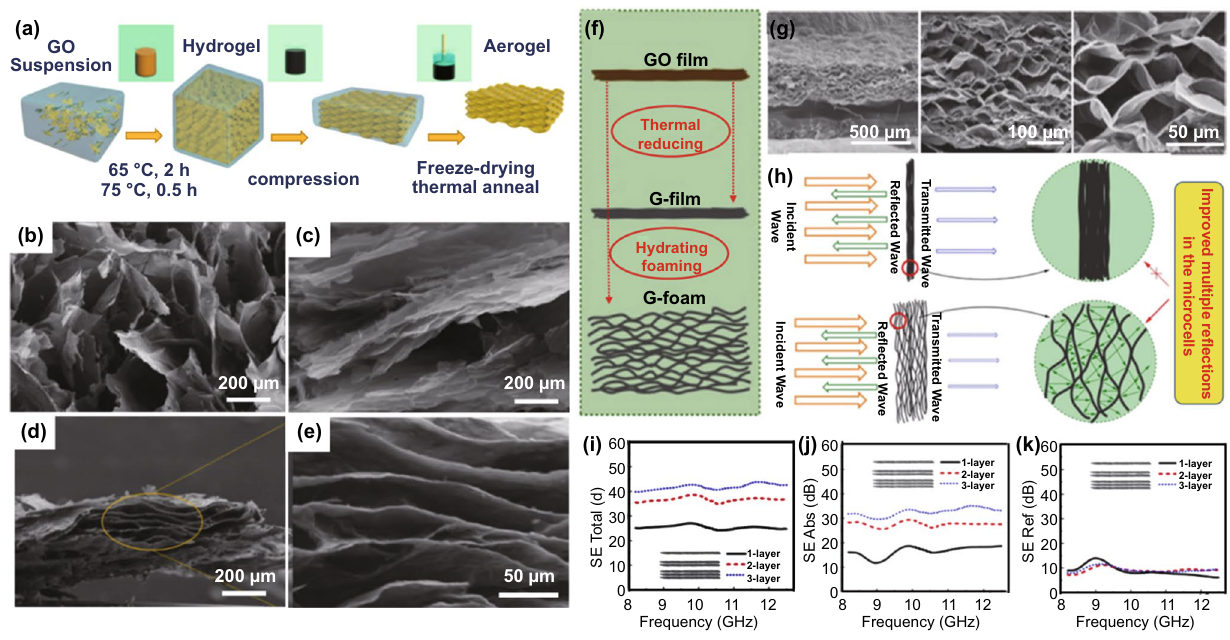
Fig. 4 a Schematic illustration of the TGA fabrication procedure; SEM images of b TGA-C100%, c TGA-C40%, d, e TGA-C5% [126]; Copy- right © 2020 American Chemical Society; f schematic representation of the fabrication process of G-film and G-foam; g SEM images show- ing microcellular structure in the cross section of G-foam; h schematic representation of multiple reflections in the microcellular structure of G-foam; i-k SE T , SE A and SE T of G-foam with different stacked layers in the frequency range of 8.2–12.5 GHz [100]. Copyright © 2016